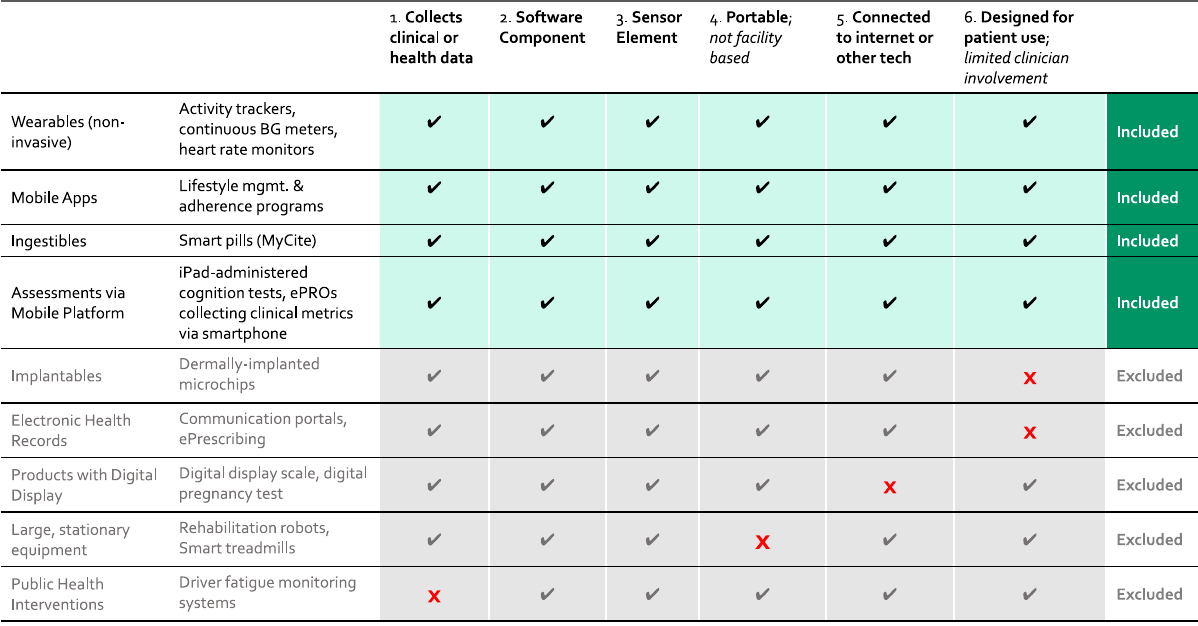
Fig. 1 De fi ning “ connected digital products ”— inclusion criteria. Products must meet all six of the criteria labeled along the top of this fi gure in order to be included in this study as “ connected digital products ” . Products that fail to meet any one of the six criteria are excluded.